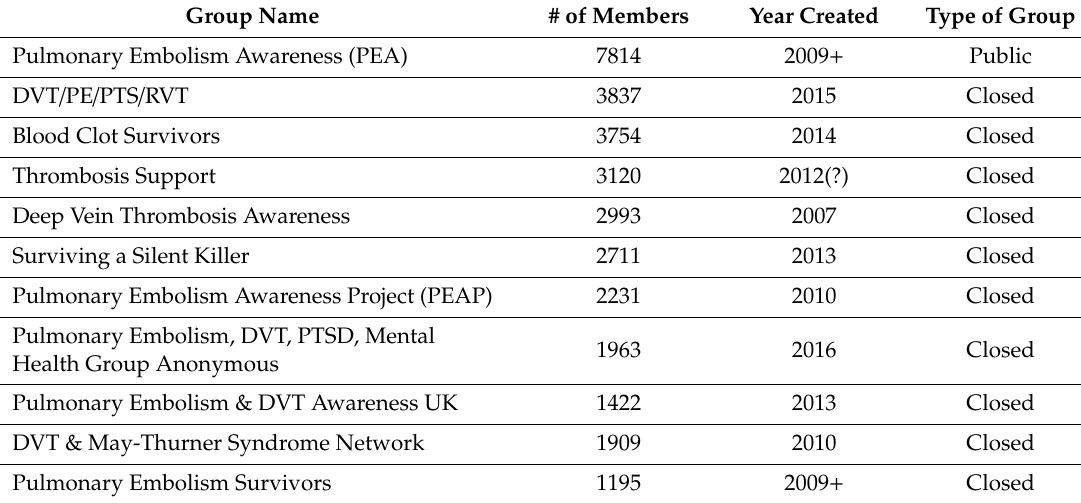
Table 1. Facebook Pulmonary Groups by